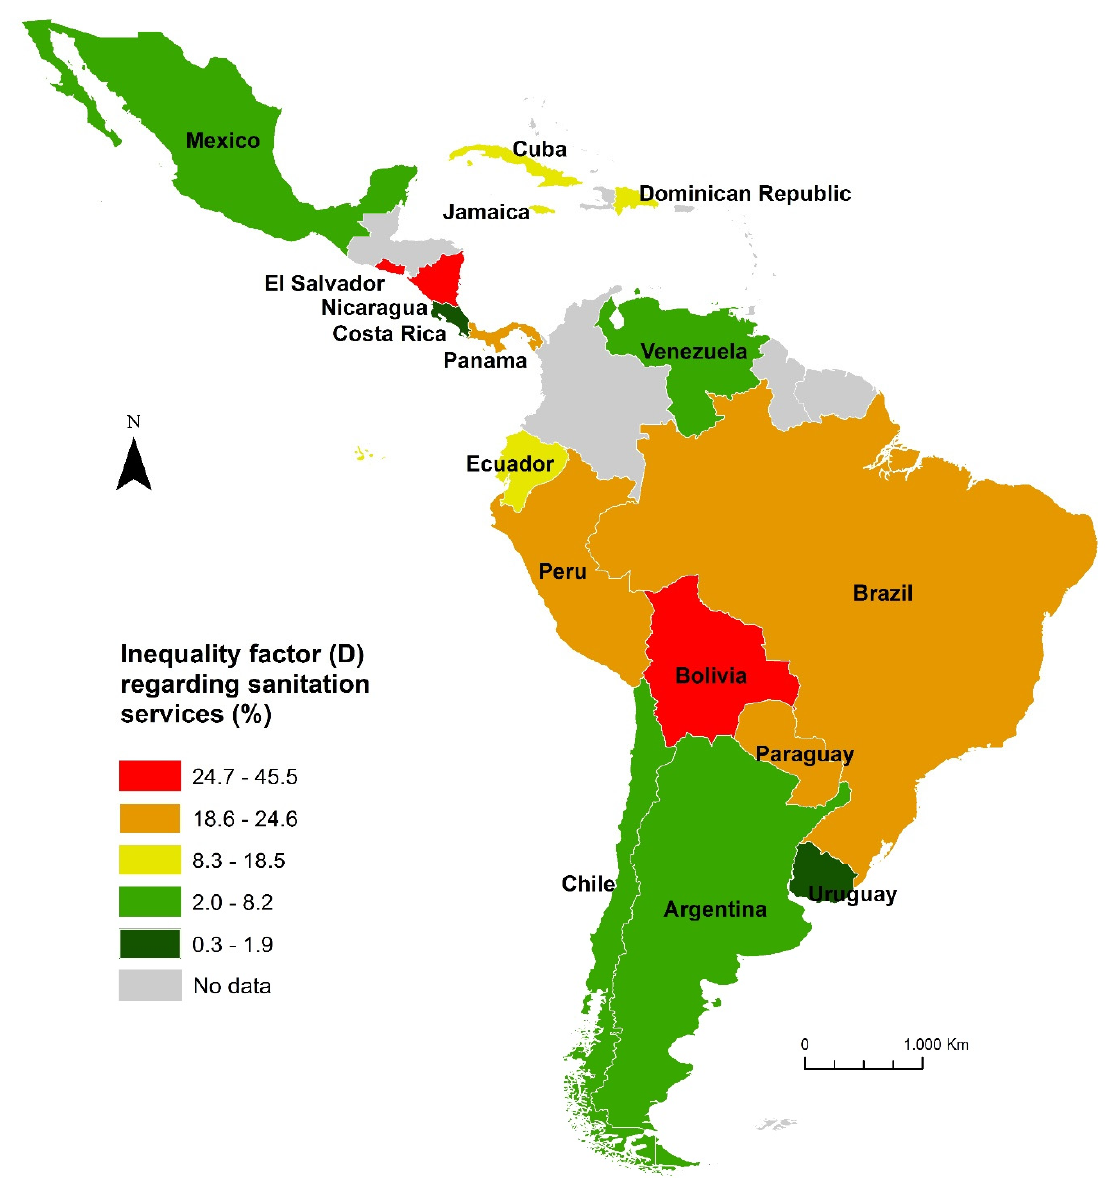
Figure 2. Inequality factor for sanitation services. (Note: For better visualization of the values, D is expressed in the map as a percentage. 0% equals perfect equality in access to services, and 100% means maximum inequality). Source: Own elaboration based on census microdata from the IPUMS-International Project